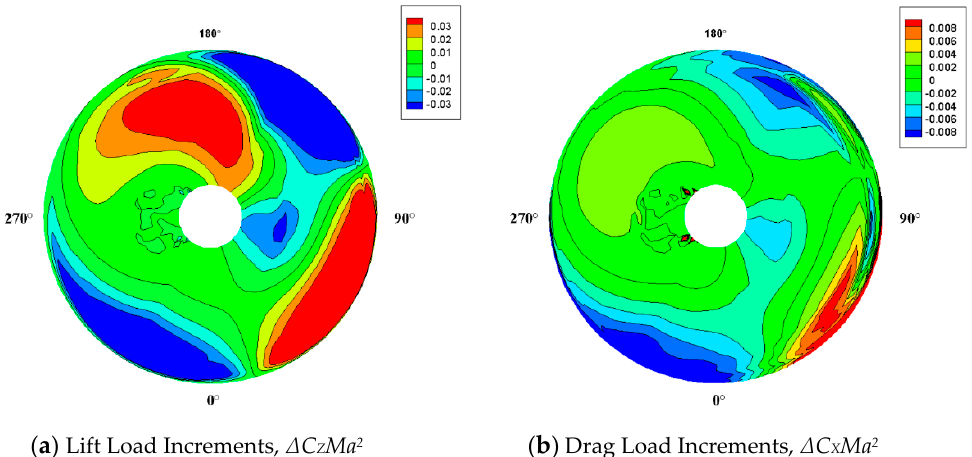
Figure 19. Dimensionless load increment distributions relative to the baseline rotor using uniform twist control with multi-harmonic inputs for condition B.